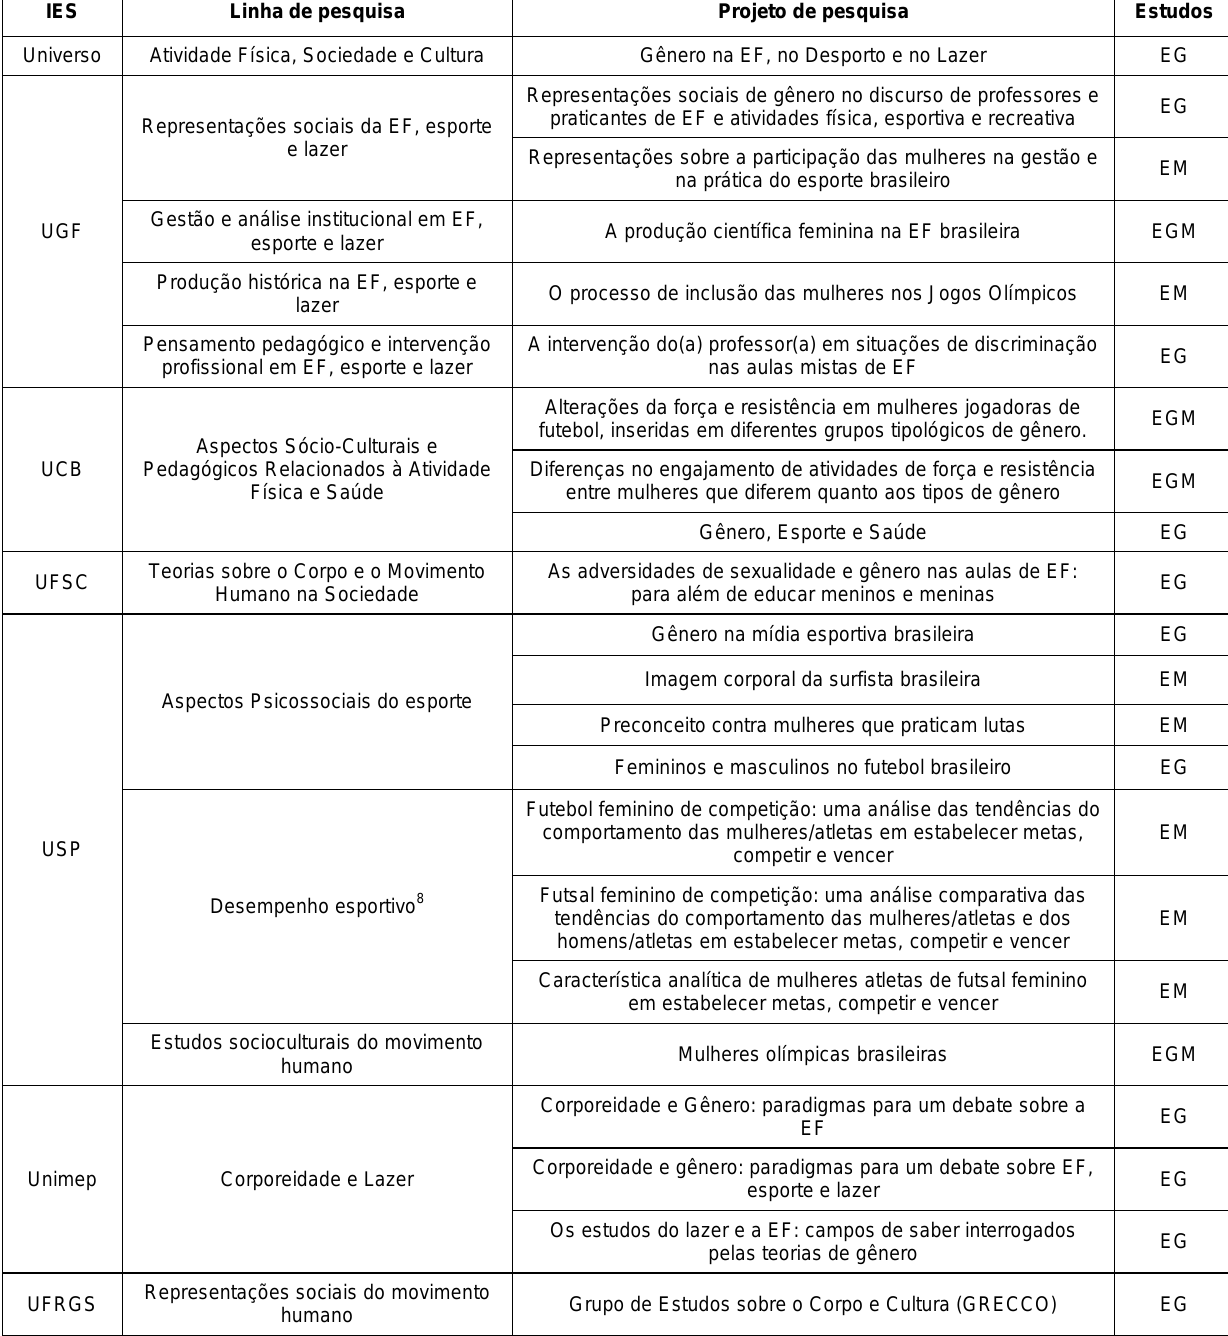
Tabela 4. PPG Stricto-Sensu em EF com Projetos de Pesquisa na área de Estudos de